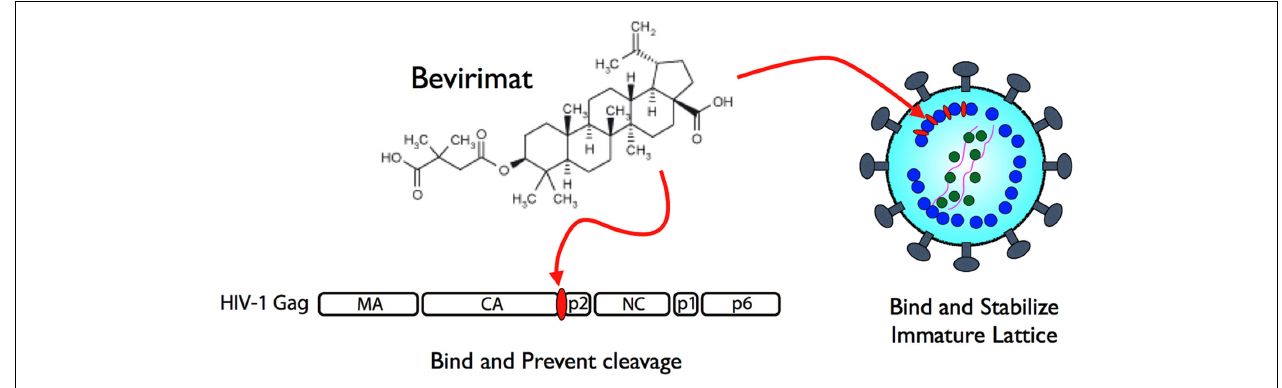
FIGURE 2 | Mechanism of action of bevirimat. It binds to CA/p2 cleavage site of HIV-1 Pr55 to prevent processing by PR (left) and also to stabilize viral core formation in immature status